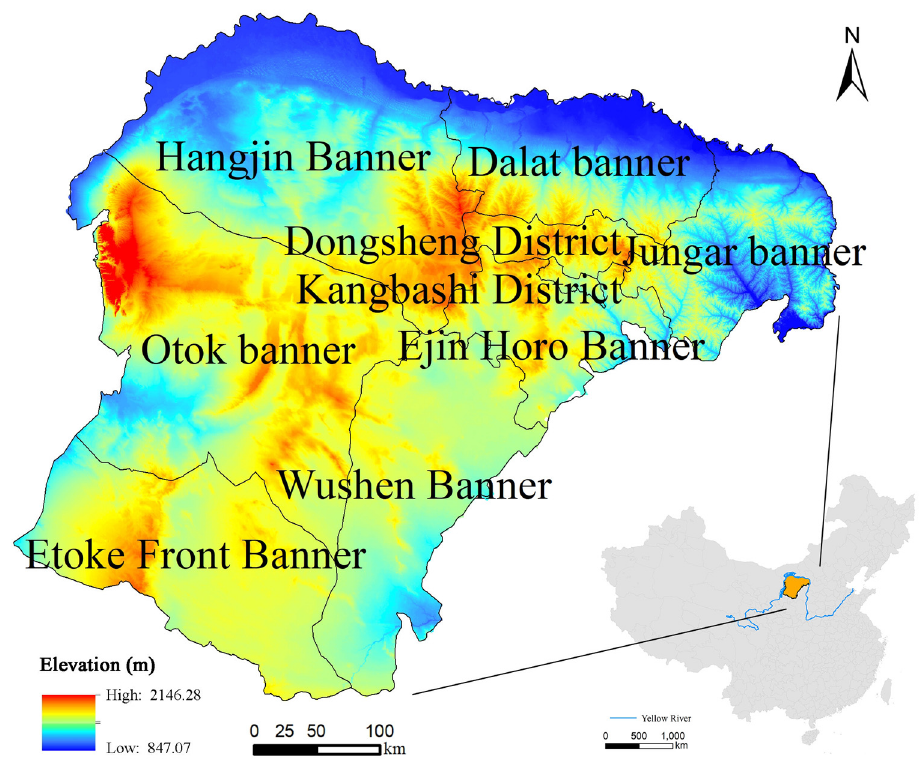
Figure 1. Geographical location of Ordos City.